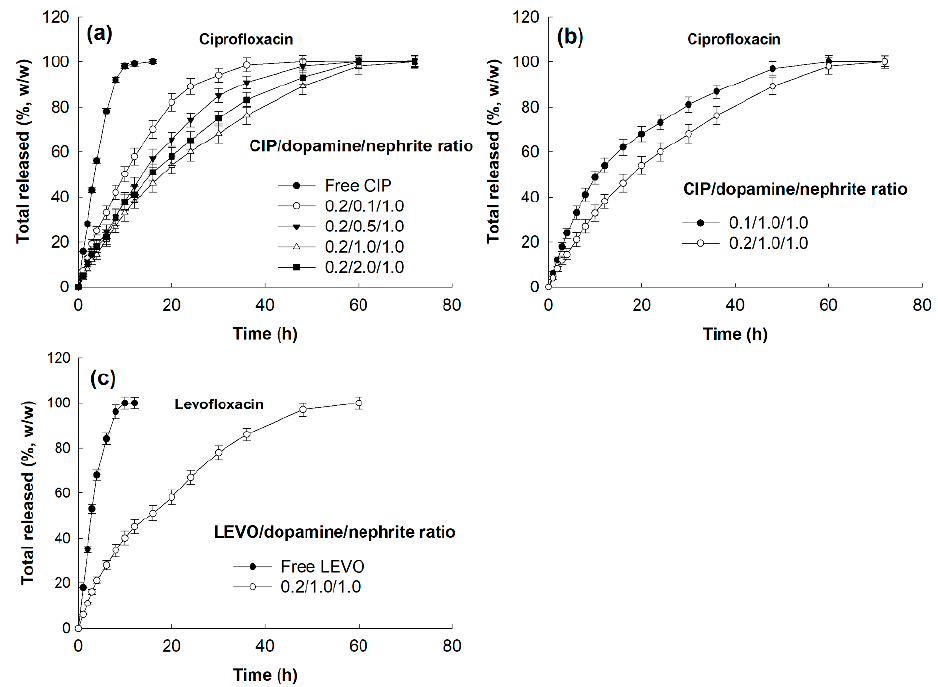
Figure 5. Comparison of pure drug liberation (Free CIP) and CIP (or LEVO) release from CIP (or LEVO)-incorporated/PDA-coated nephrite composites. ( a ) The effect of dopamine ratio on the CIP release from CIP-incorporated/PDA-coated nephrite composites. ( b ) The effect of CIP weight ratio on the CIP release from CIP-incorporated/PDA-coated nephrite composites. ( c ) LEVO release from LEVO-incorporated/PDA-coated nephrite composites. LEVO/PDA/Nephrite: LEVO-incorporated/PDA-coated nephrite composites.